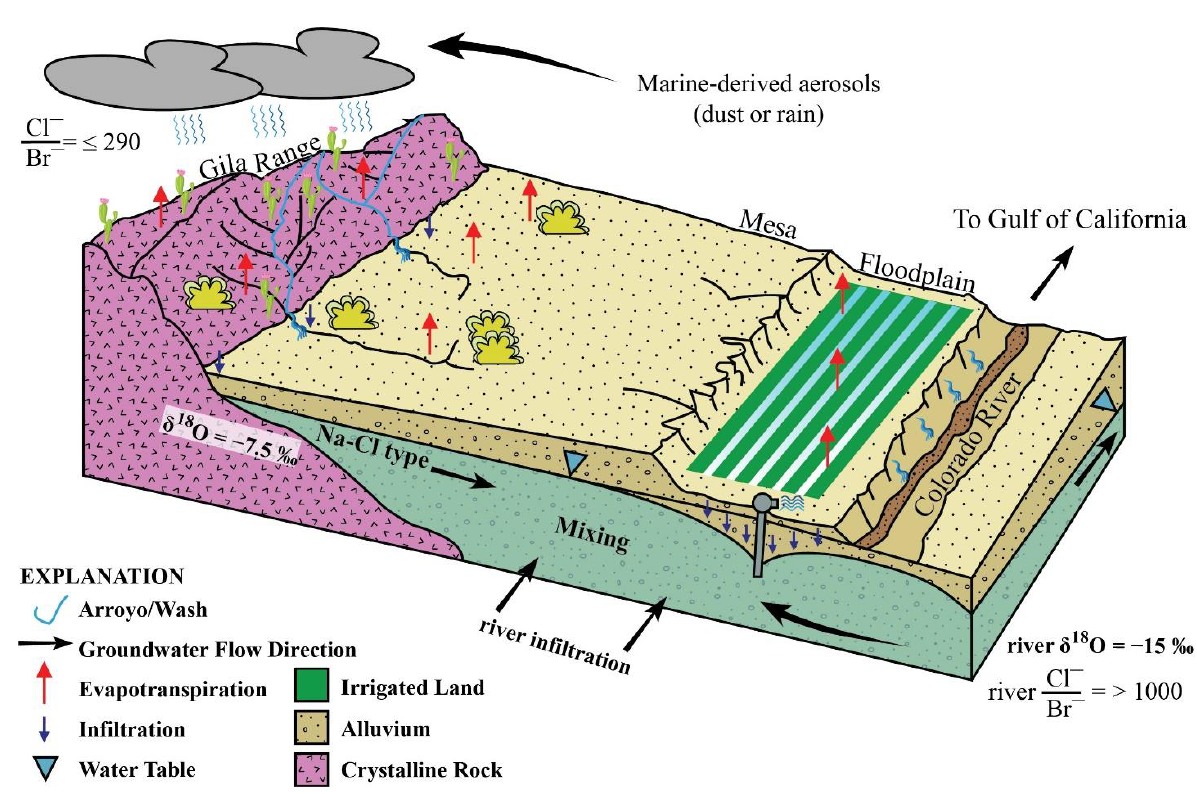
Figure 15. Conceptual model of the study area.